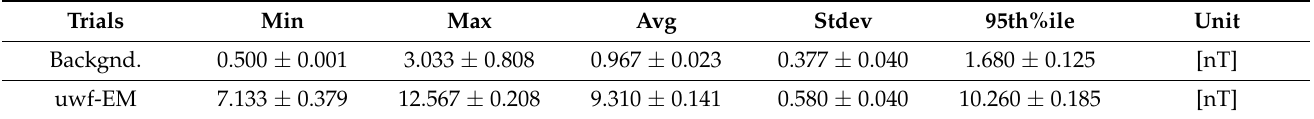
Table 6. Magnetic flux densities of the background with the antenna in operation stated as averages along with standard deviations of three replicates. Background values denote the signal strength with both the inactivated antenna and cell culture placed in the mu-metal test box, whereas uwf-EM measurements denote the emitted field intensities when the antenna was operational. Trials Min Max Avg Stdev 95th%ile Unit Backgnd.